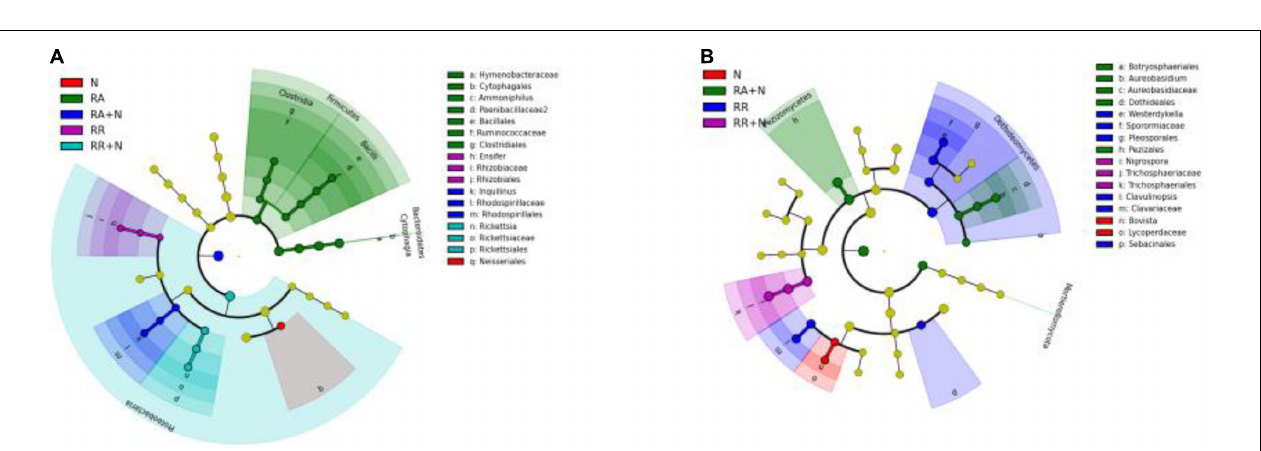
FIGURE 3 | The effects of altered nitrogen addition and rainfall, and their interaction, on the relative abundance of dominant members of the bacterial (A) and fungal (B) communities in August 2018. Different treatments: Con: Control; RR: Rainfall reduction; RA: Rainfall addition; N: Nitrogen addition; RR + N: Rainfall reduction and Nitrogen addition; RA + N: Rainfall addition and Nitrogen addition.